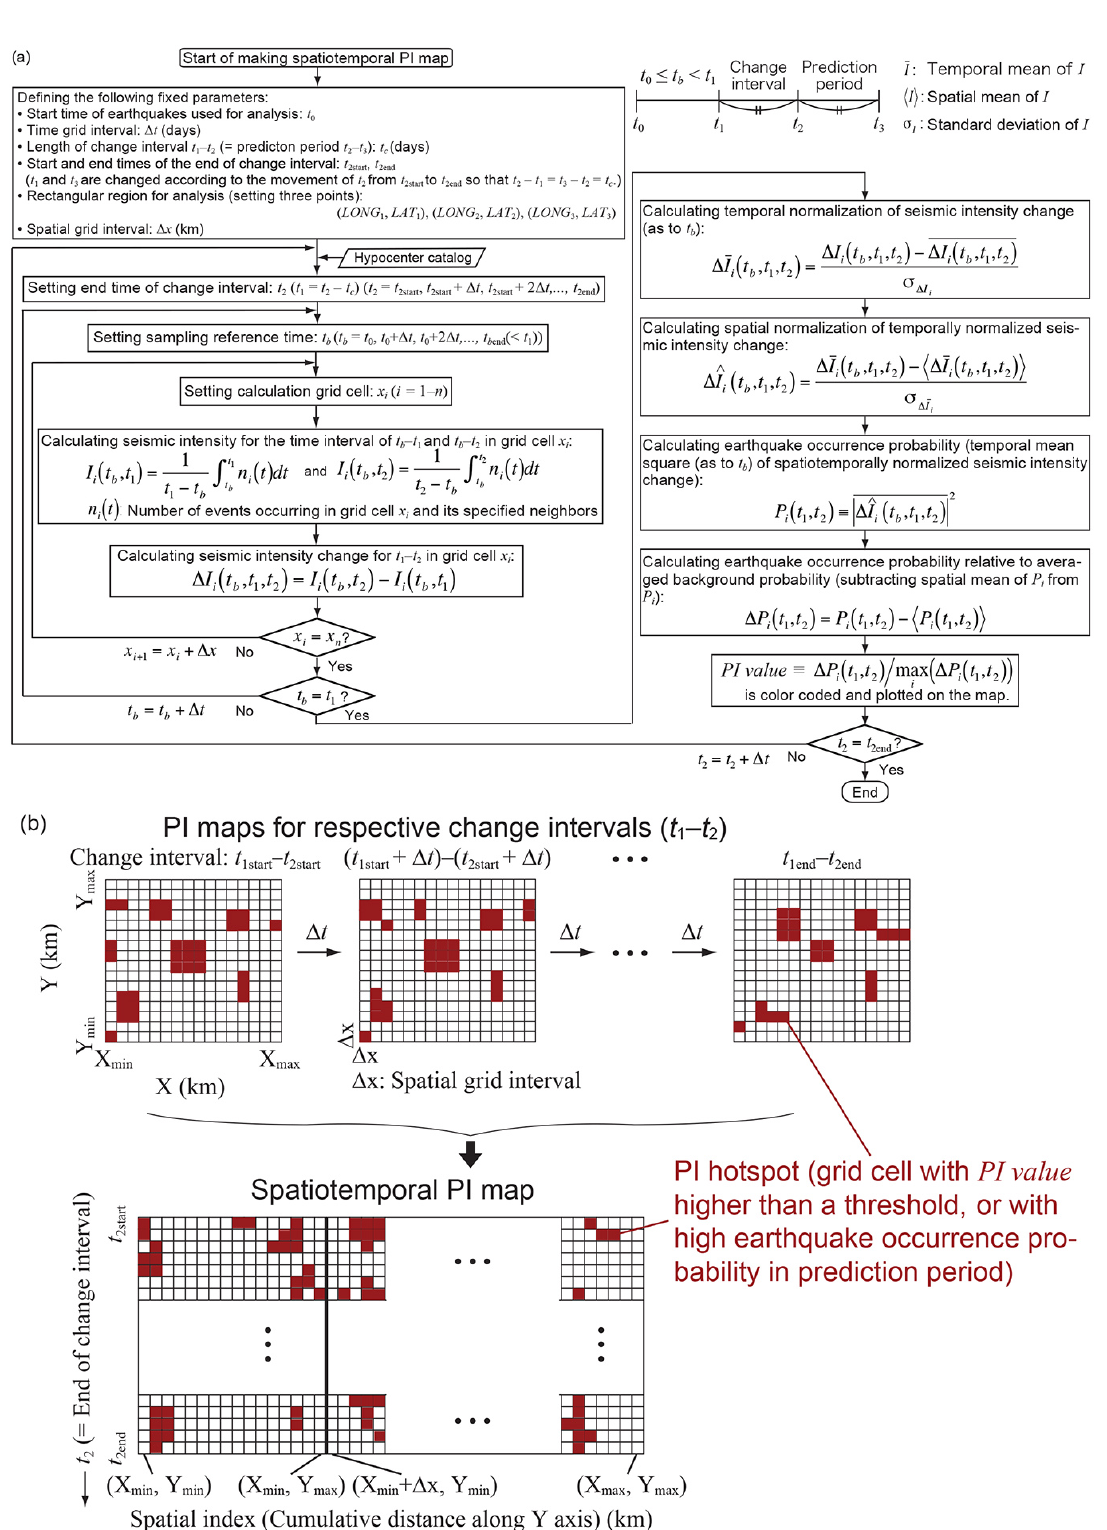
Fig. 2. (a) Flowchart of the procedure for obtaining PI maps, which illustrate the spatial distribution of grid cells with large seismicity changes above a particular threshold (referred to as PI hotspots). (b) Illustration of the method for obtaining the spatiotemporal PI map obtained by combining PI maps obtained based on the process described in (a) . The X and Y axes in each PI map correspond to those of the rectangular region in each panel of Fig. 1. The thick vertical black line in the spatiotemporal PI map represents the edges of the Y axis range. Nat. Hazards Earth Syst. Sci., 14, 849–859,